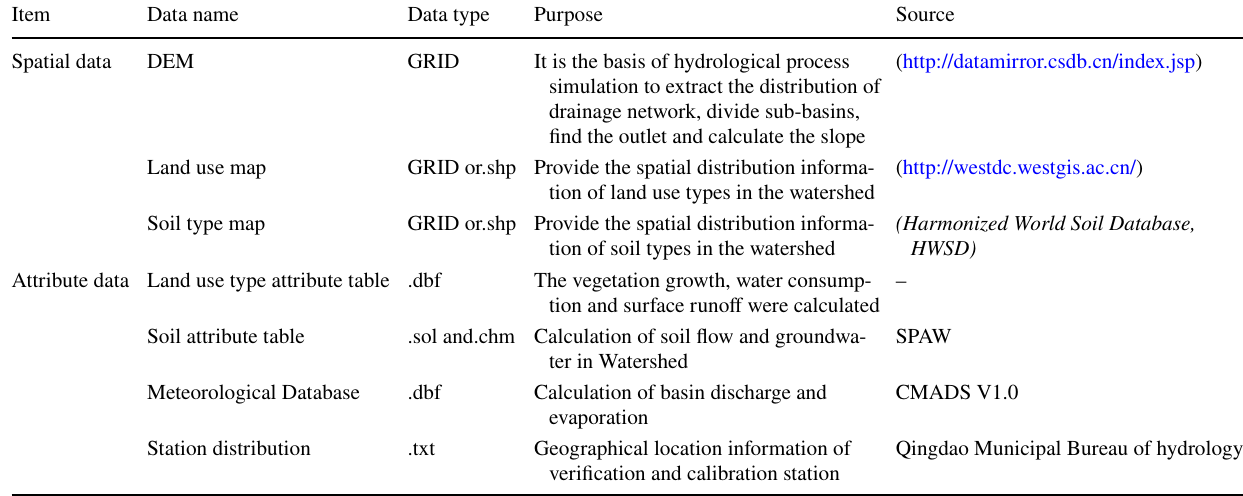
Table 1 SWAT model basic data description